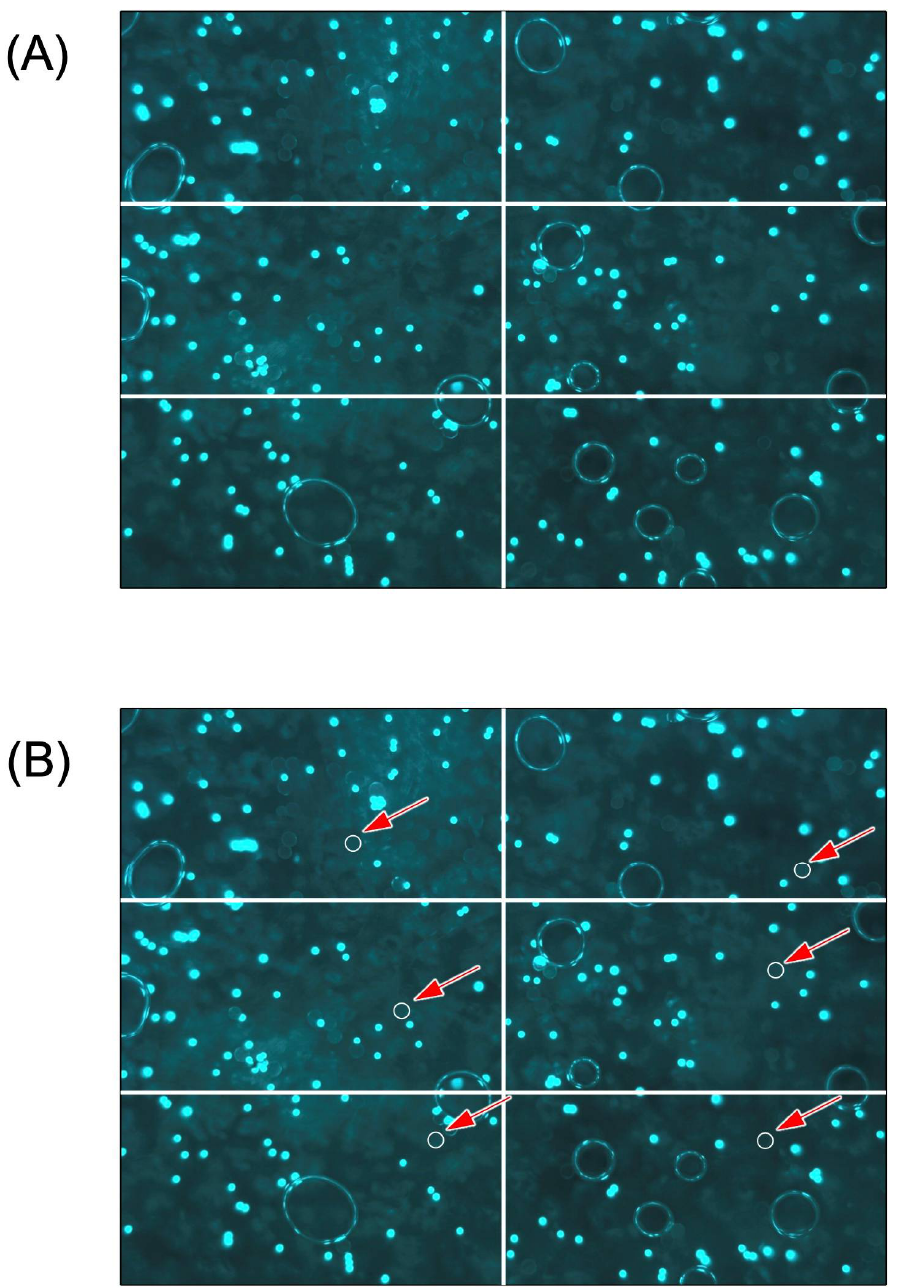
Figure 2. Fluorescent microscopic image of PE microplastics stained with Nile Red and URFP-100 particles ( A ). The image was divided into six areas and a single independent particle was selected for each area (pointed out by red arrows in ( B ) for analysis of fluorescent intensity. URFP-100 was used as the standard for fluorescent intensity between